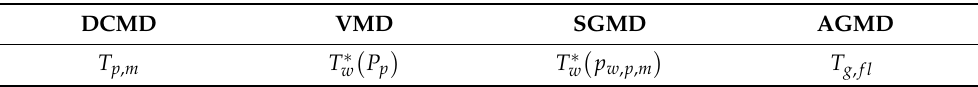
Figure 2. Saturated temperatures of water equivalent to vapor pressure depression, moisture content of air, and vacuum pressure. The values of a and b are 0.988 and 0.0492, respectively, obtained from the exponential curve fitting of vapor pressure vs. temperature from the Antoine equation. Table 4. Equivalent saturation temperature ( T ∗ p ) for partial pressure of water in the permeate side.